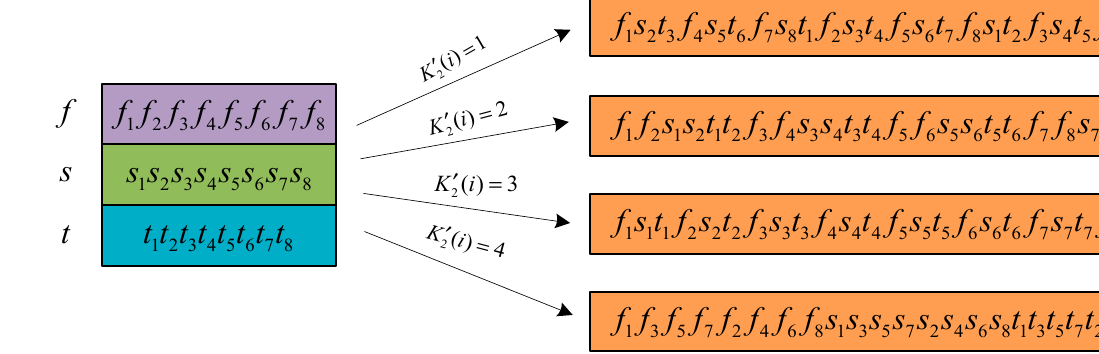
Figure 5. Schematic diagram of the way of bit recombination.